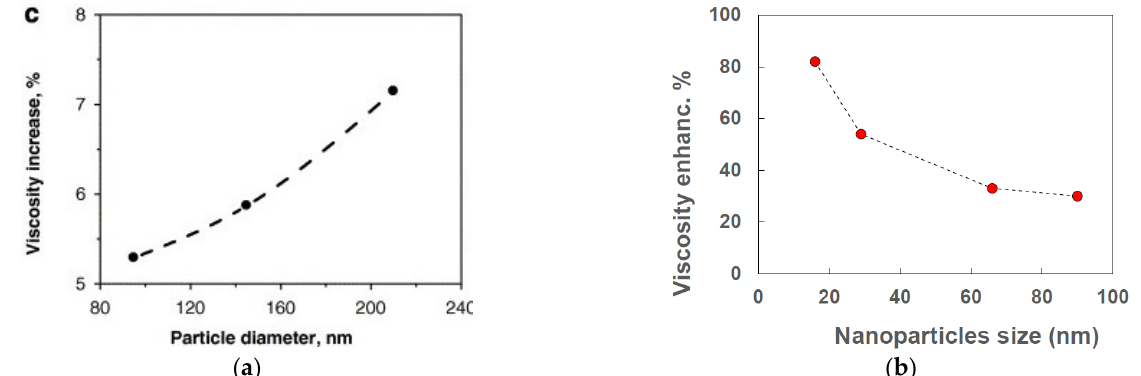
Figure 4. Influence of nanoparticle size on ( a ) viscosity [44] and ( b ) thermal conductivity and viscosity [40] of two different nanofluids.